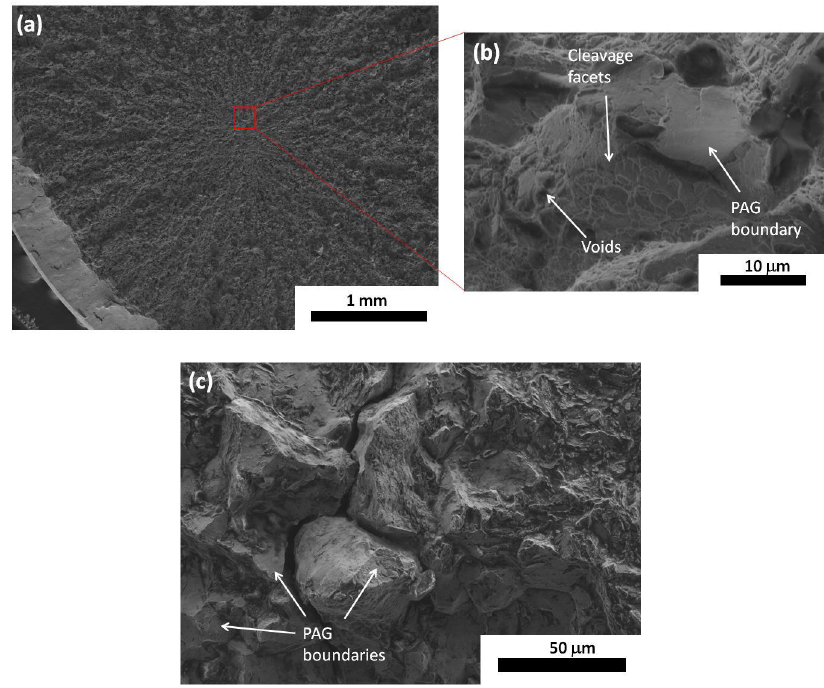
Figure 7. Fracture surface of tensile specimens of two nanobainitic structures of the same steel [54], treated at 250 °C ( a ), detail of the crack initiation site in ( b ), and treated at 220 °C ( c